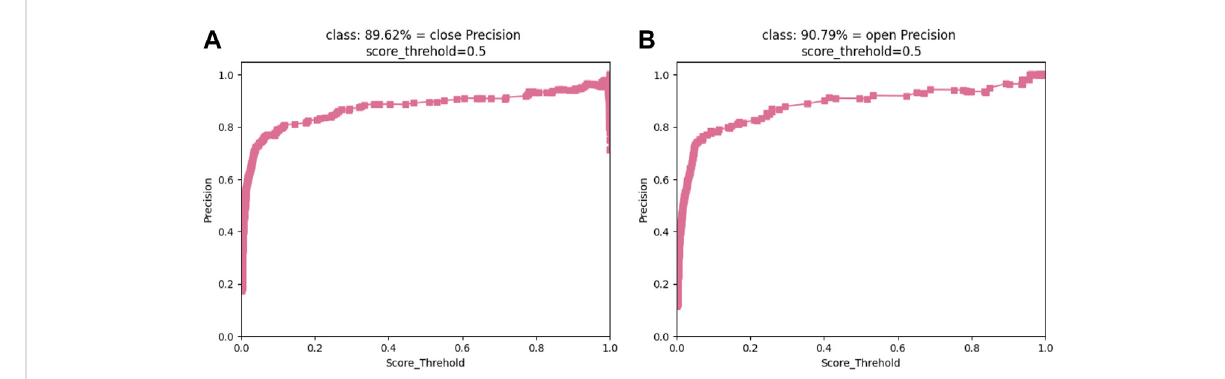
FIGURE 7 Precision of improved YOLOv4 model. (A) close precision; (B) open precision.